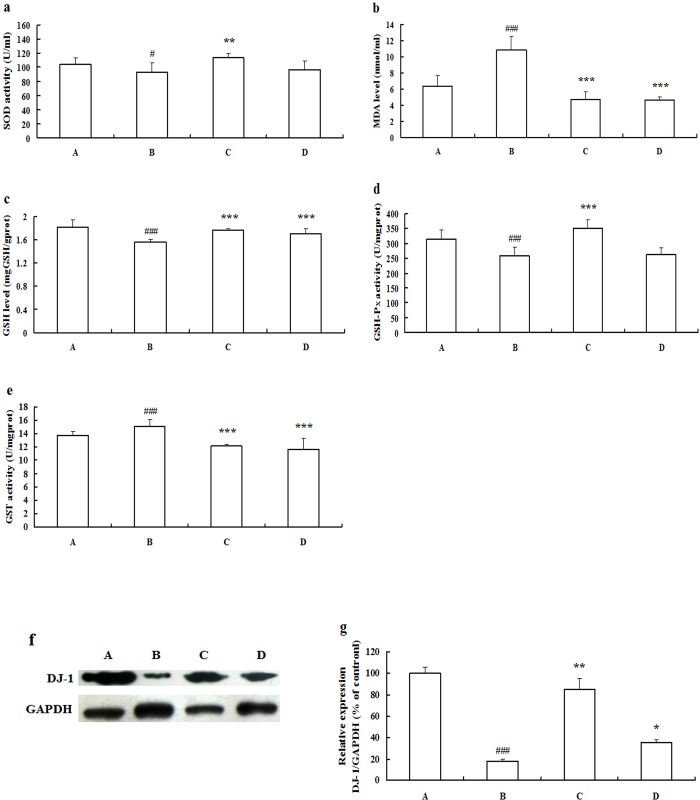
Effects of ZYC-1 on oxidative stress in the liver of rats treated with DMN.(a) SOD activities, (b) MDA levels, (c) GSH levels, (d) GSH-PX activities and (e) GST activities. (f) The expression level of DJ-1 protein was detected by Western blot, and the gels have been run under the same experimental conditions. Cropped blots are used in (f), and full-length blots are presented in supporting information (S4 Fig). Densitometry analysis is presented as the relative ratio of protein (DJ-1)/GAPDH using Quantity One software. The data represent the mean ± SD. A: normal group; B: DMN model group; C: ZYC-1 treatment group; D: IFN-α2b treatment group. #P < 0.05, ##P < 0.01, ###P < 0.001 vs. normal group, *P < 0.05, **P < 0.01, ***P < 0.001 vs. DMN model group.